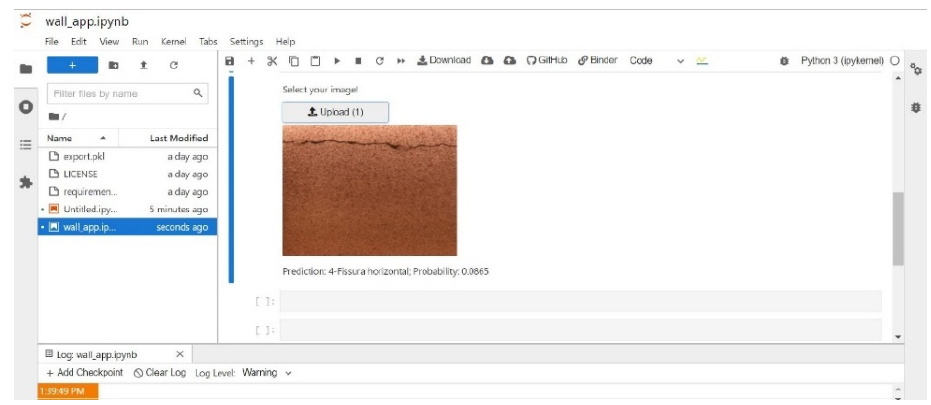
Figure 8. Example of anomaly classification by means of DL model: horizontal crack.